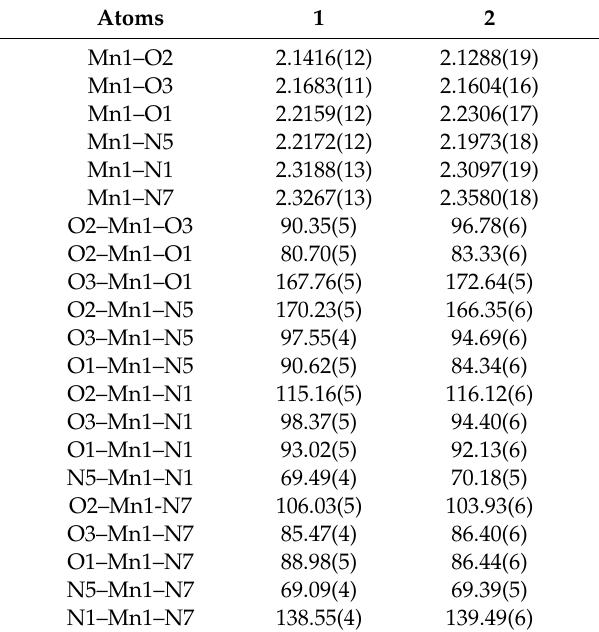
Figure 2. Structure and atomic numbering of the symmetric unit of 1 and 2 . Thermal ellipsoids were drawn at 50% probability level. Moreover, the nitrate counter ions were omitted for better clarity. Table 2. The most important bond distances and angles of 1 and 2 .